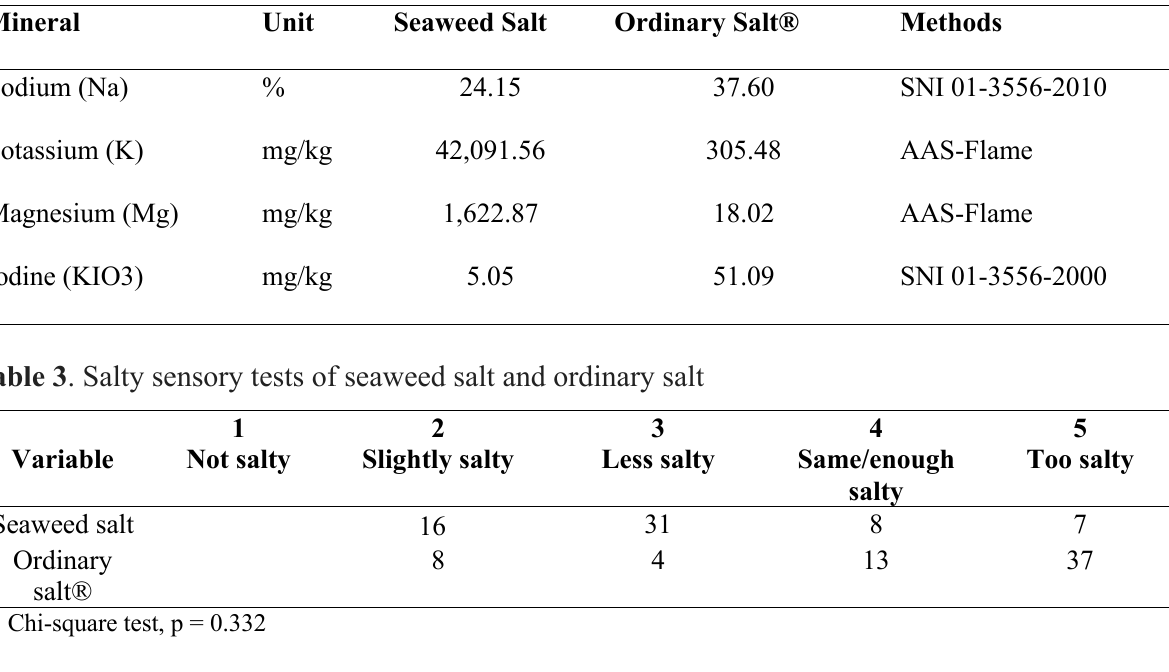
Table 2. Mineral analysis of seaweed salt and ordinary salt powder SUCOFINDO